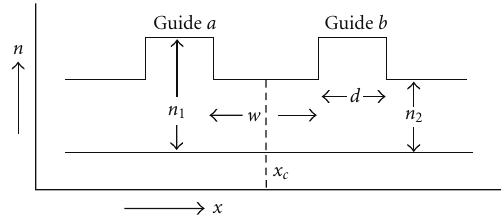
Figure 1: Structure of a coherent directional